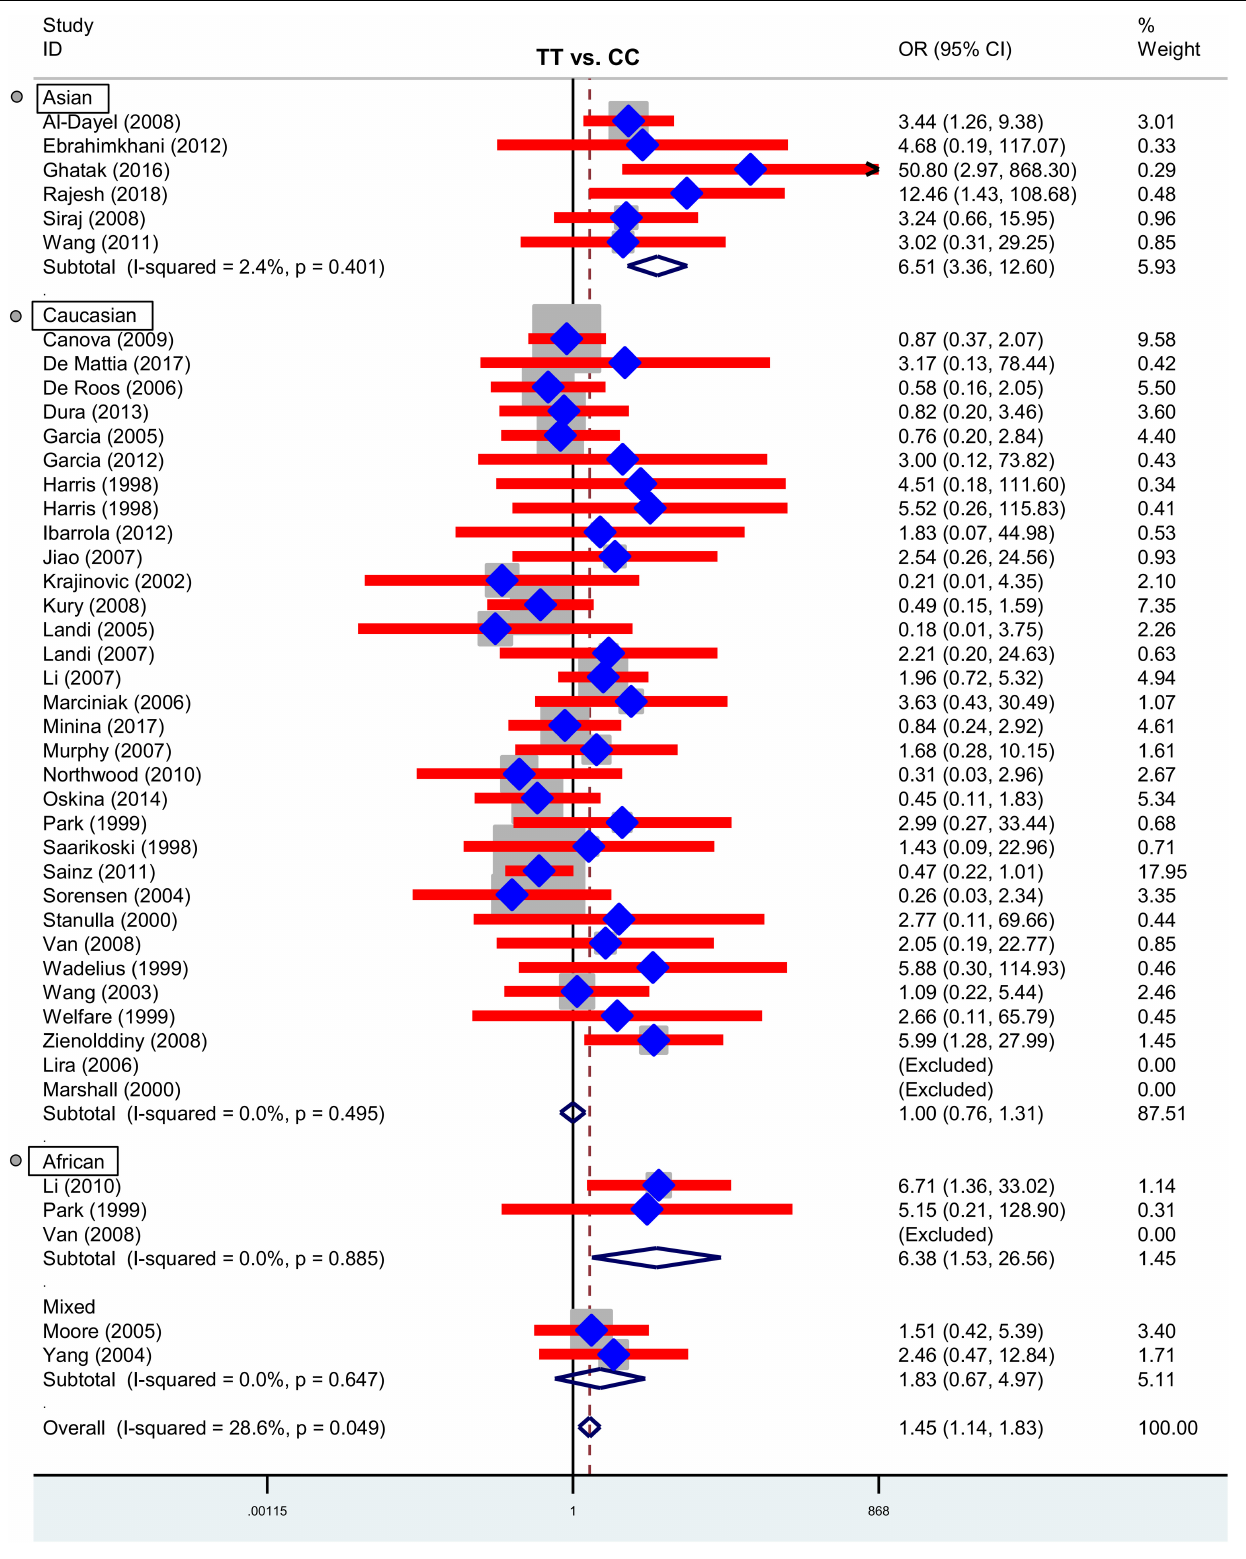
FIGURE 2 | Forest plot of the subgroup analysis by ethnicity in the overall population (TT vs. CC model).